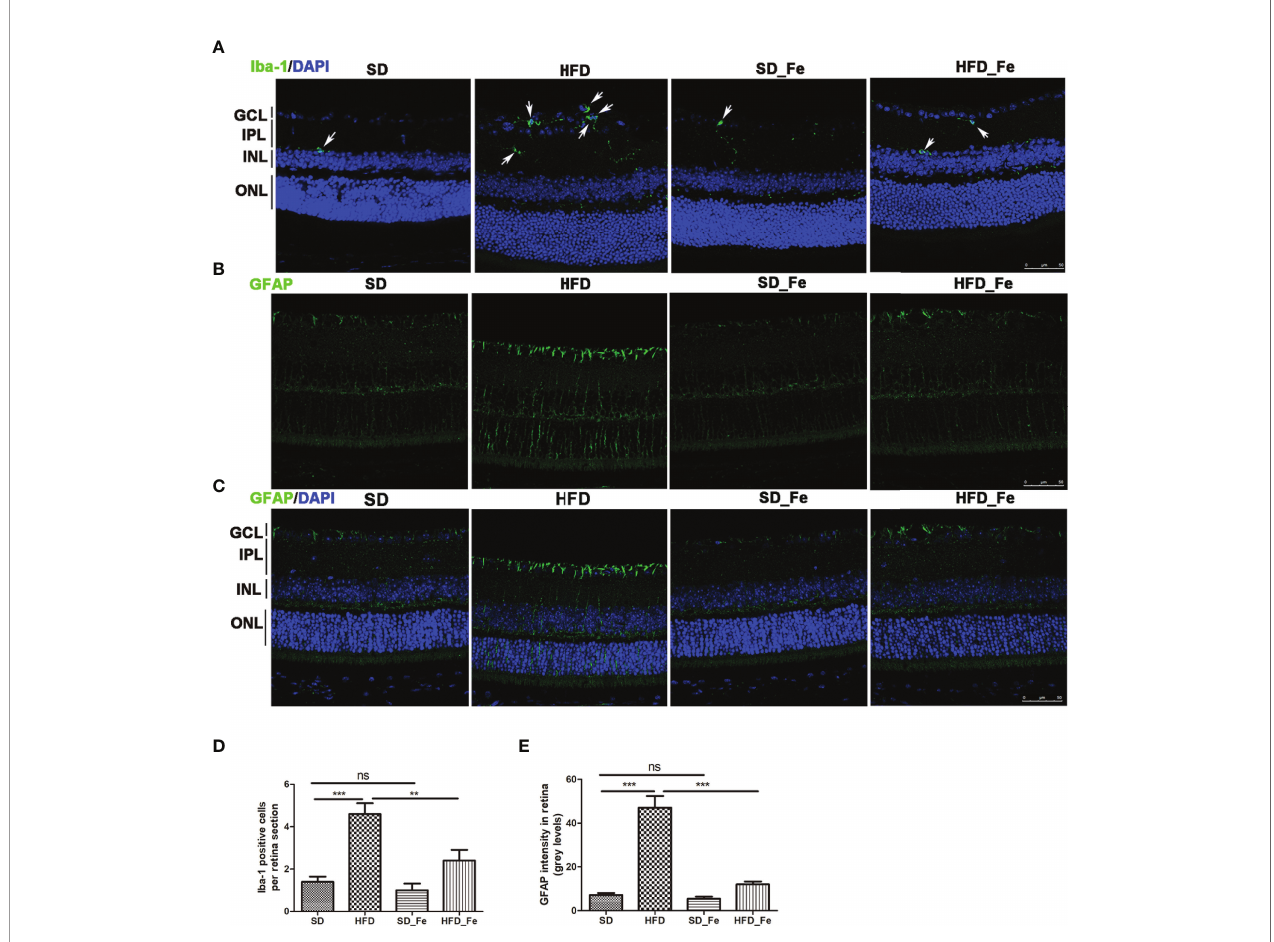
FIGURE 3 | Effect of feno fi brate on the microglia and Müller cells in the retina of high-fat diet (HFD)-fed mice. (A) Representative images of immuno fl uorescence staining of Iba-1 showed microglia cells in retina (green: Iba-1, blue: DAPI). The white arrows indicated positive staining of Iba-1. (B, C) Representative images of immuno fl uorescence staining of GFAP (a Müller glial activation marker) in retina (green: GFAP, blue: DAPI). (D) Quanti fi cation of Iba-1 positive cell. (E) The fl uorescent intensity of GFAP in retina. Scale bars: 50 m m (A – C) . SD group, standard diet group; HFD group, high-fat diet group; SD_ Fe group, standard diet plus feno fi brate group; HFD_ Fe group, high-fat diet plus feno fi brate group. GCL, ganglion cell layer, IPL, inner plexiform layer, INL, inner nuclear layer, ONL, outer nuclear layer. n = 5; ns, not signi fi cant; **P < 0.01; ***P < 0.001. Bar graphs represent mean values ±